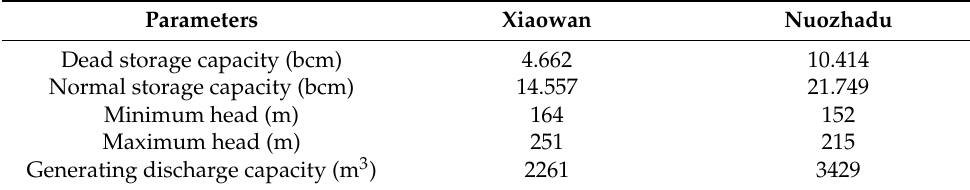
Table 1. The basic parameters of the reservoirs.